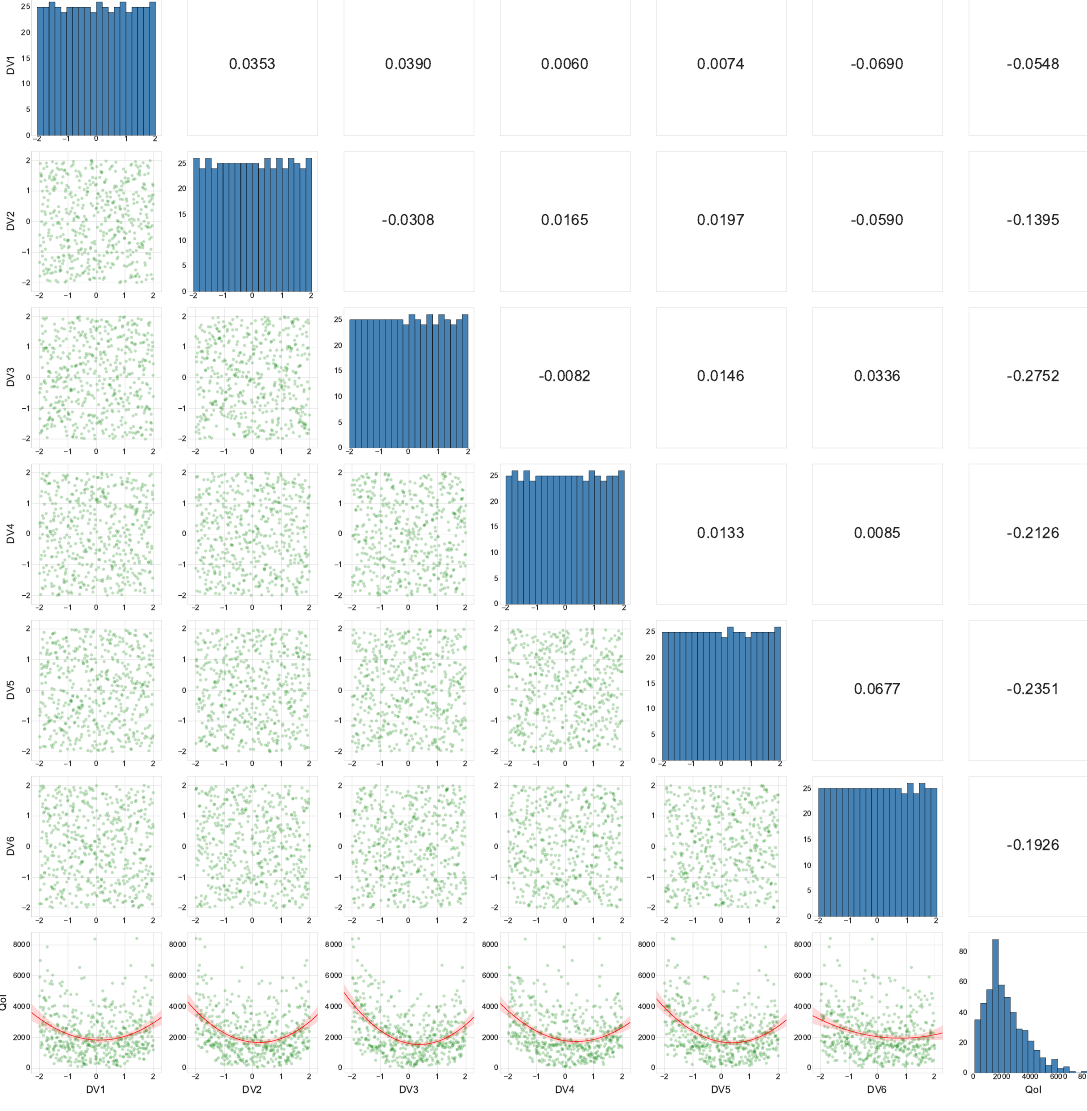
Figure 5. Scatterplot matrix of the high-dimensional Rosenbrock function space exploration study ( d = 6). The Spearman correlation is shown in the upper triangular part of the matrix. In the diagonal of the matrix, the histograms showing the data distribution are displayed. In the lower triangular part of the matrix, the data distribution is shown using scatterplots. In the last row of the matrix plot, the response of the quantity of interest (QoI) in function of the design variables is illustrated, together with a quadratic regression